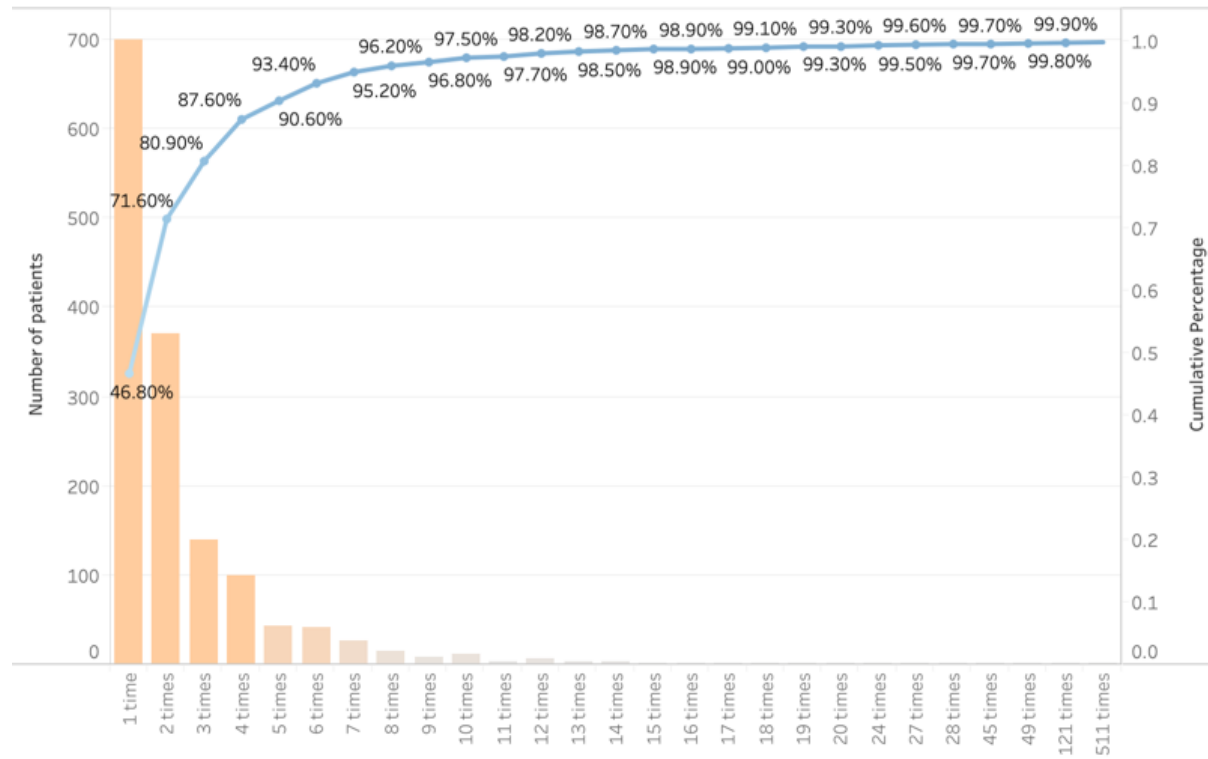
Figure 4. Posting times per